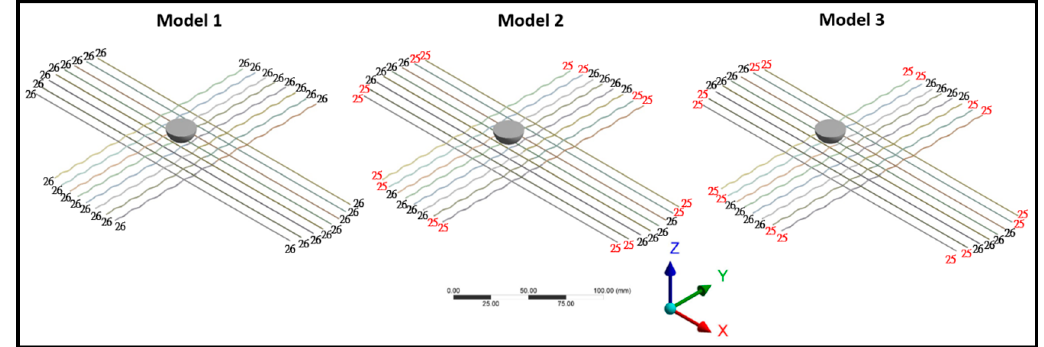
Figure 2. Three models for simulating the response due to nonuniform string tension and different impact location.